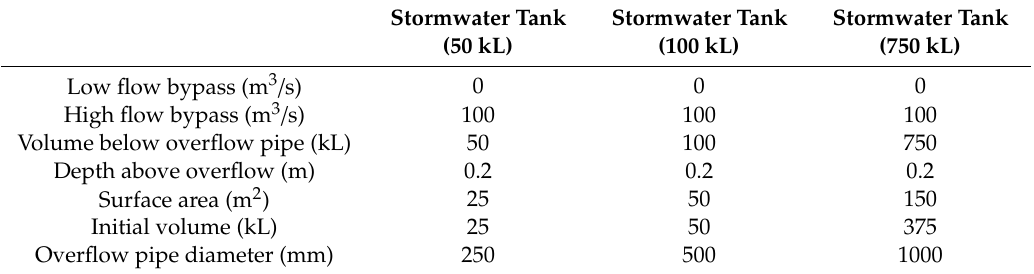
Figure A1. The schematic diagram of stormwater tank [112]. Table A1. Parameters of four types of stormwater tanks in